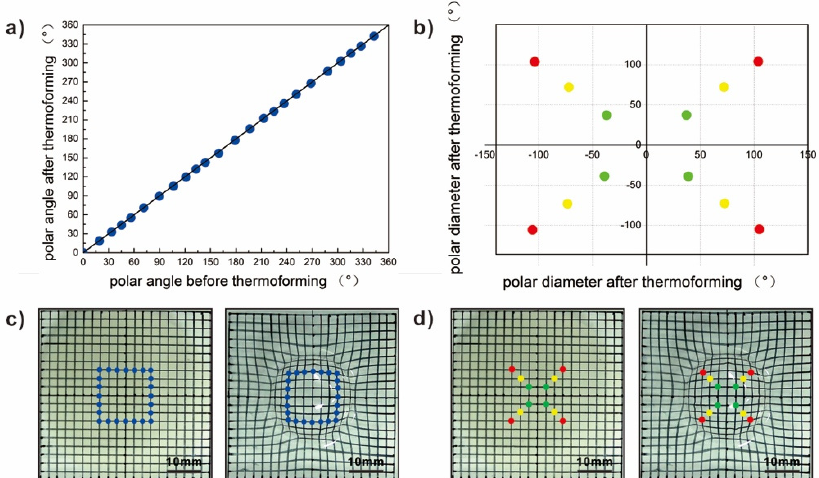
Figure 2. The circumferential and radial consistency of the thermal bonding films and polycarbonate (PC)-laminated structures in the process of conforming: ( a ) The variation of the polar angle after thermoforming for those marked positions; ( b ) the variation of the polar diameter after thermoforming for those marked positions; ( c ) the locations of those circumferential points; and ( d ) the locations of those radial points.